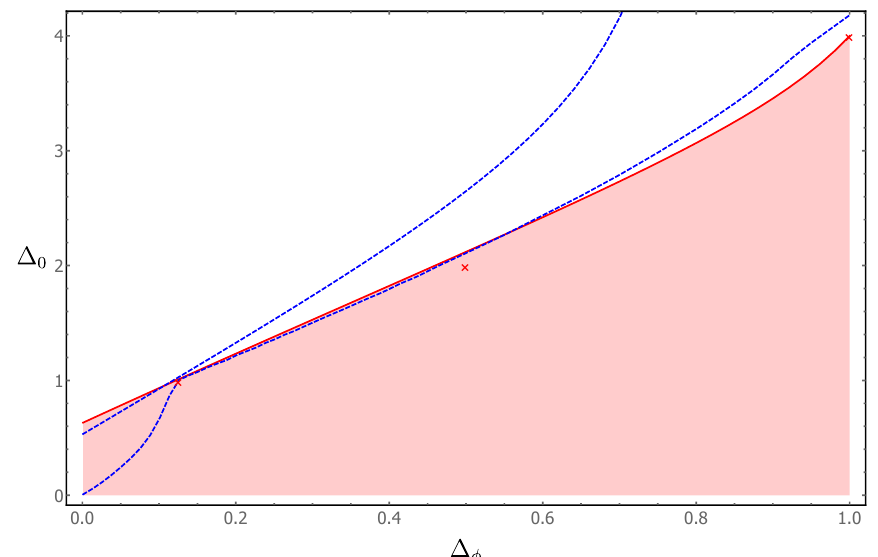
Figure 4 . Scaling dimension bound. The thick red curve is the best bound with a basis